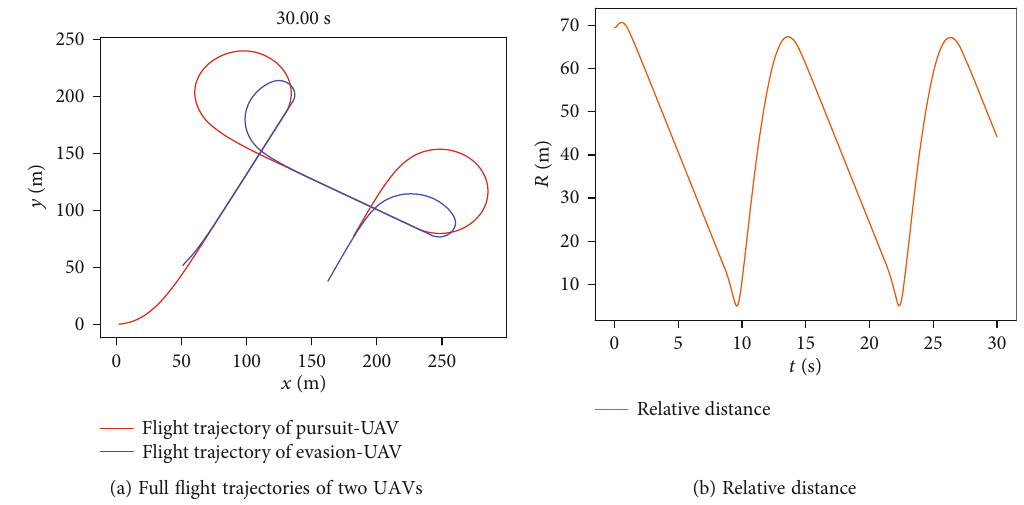
Figure 8: The evasion-UAV with the classic escape strategy.